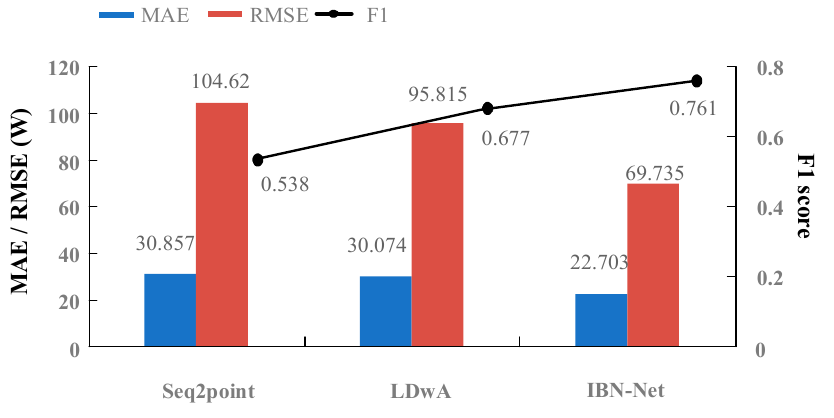
Figure 8. Comparison of CTL experimental results.